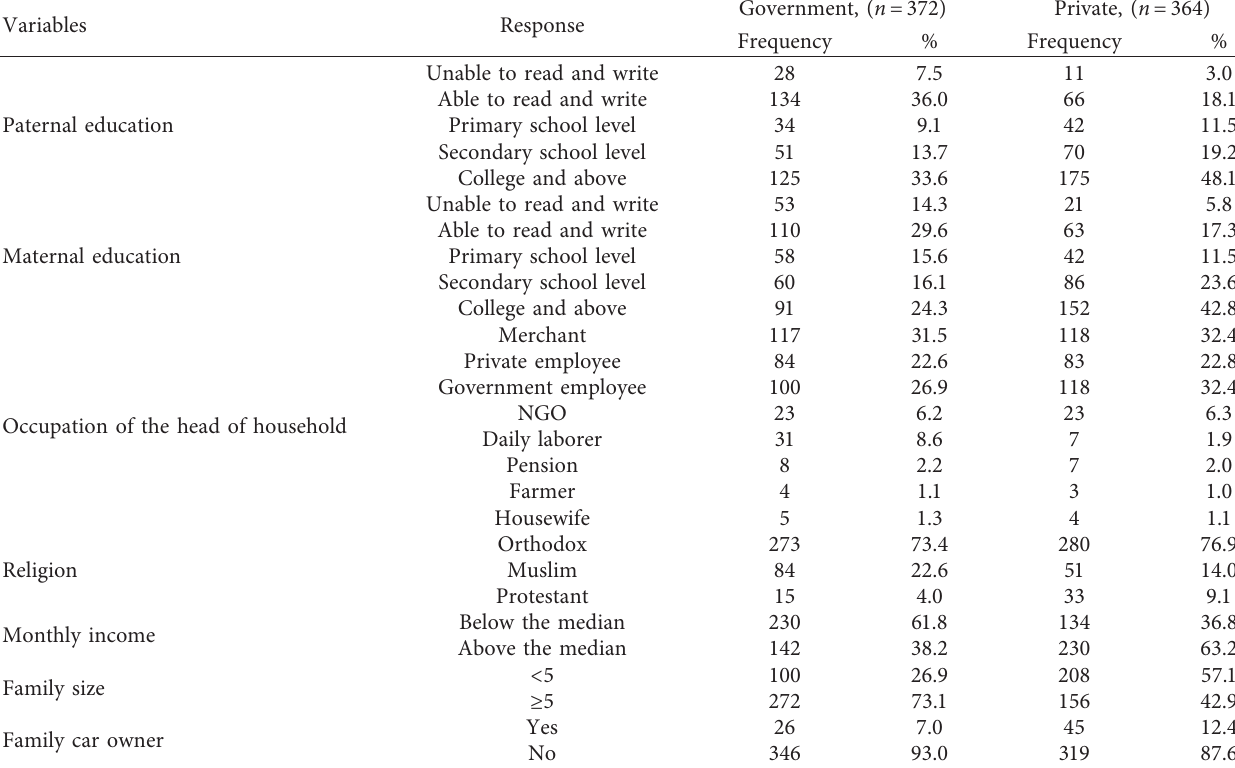
Table 1: Parents sociodemographic characteristics among primary school students in Gondar town, 2019 ( n � 736). Variables